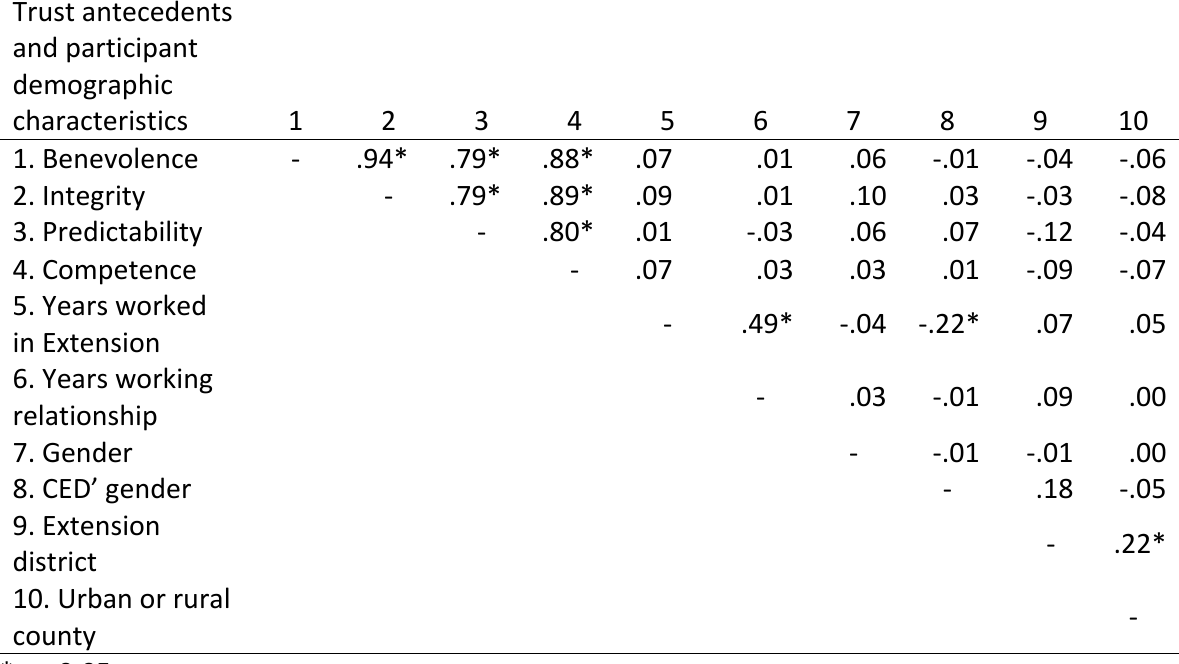
Table 6 Correlations Matrix between Trust Antecedents and Participant Demographic Characteristics Trust antecedents and